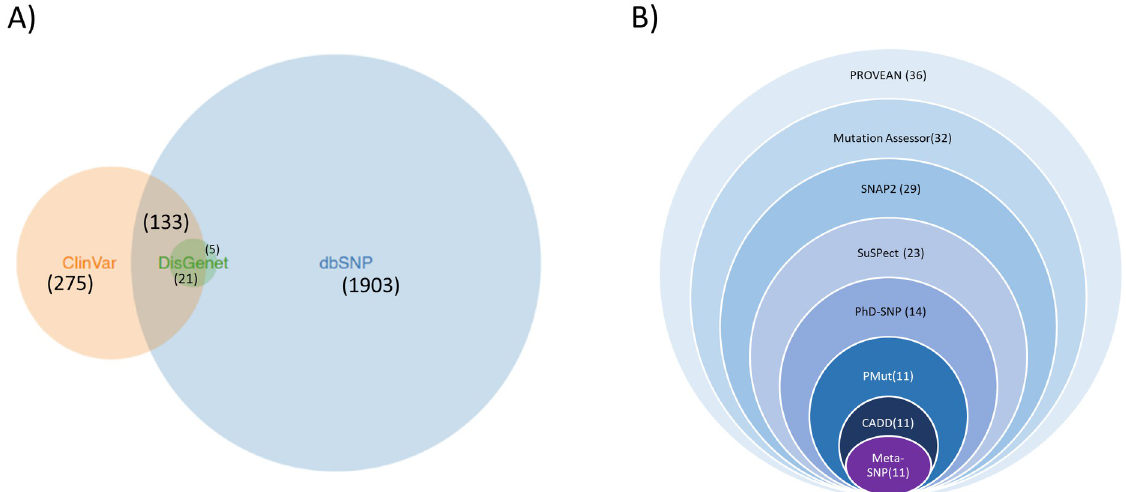
Fig 2. Retrieval and Identification of most deleterious nsSNPs. A) Retrieval of nsSNPs from three different databases: dbSNP, ClinVar, and DisGenet. The numbers in brackets indicate how many nsSNPs were retrieved from each database and how many overlapped between different databases. B) Identification of the most potentially harmful and pathogenic nsSNPs through bioinformatics analyses. The numbers in the bracket after each tool represent how many deleterious nsSNPs resulted from the previous analysis overlapped with the results from the current analysis. After 10 different tools were applied, eleven nsSNPs were selected as potentially most